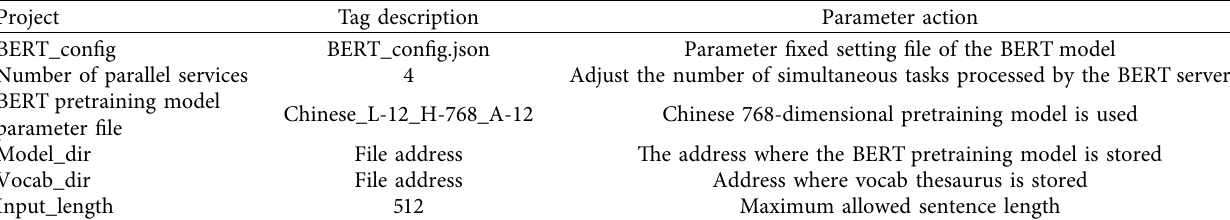
Table 1: The main parameters of the BERT